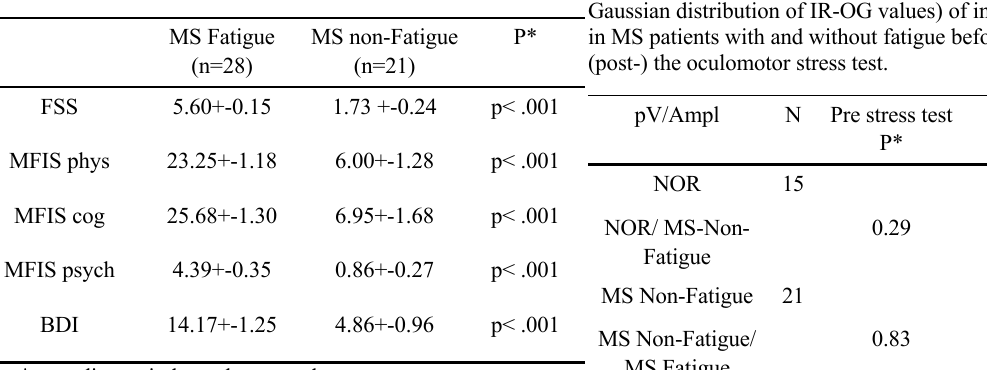
Table 2. Self-report measures of fatigue and depression. Table 3. Statistical results (student´s t-test in confirmed Gaussian distribution of IR-OG values) of infrared oculography in MS patients with and without fatigue before (pre-) and after (post-) the oculomotor stress